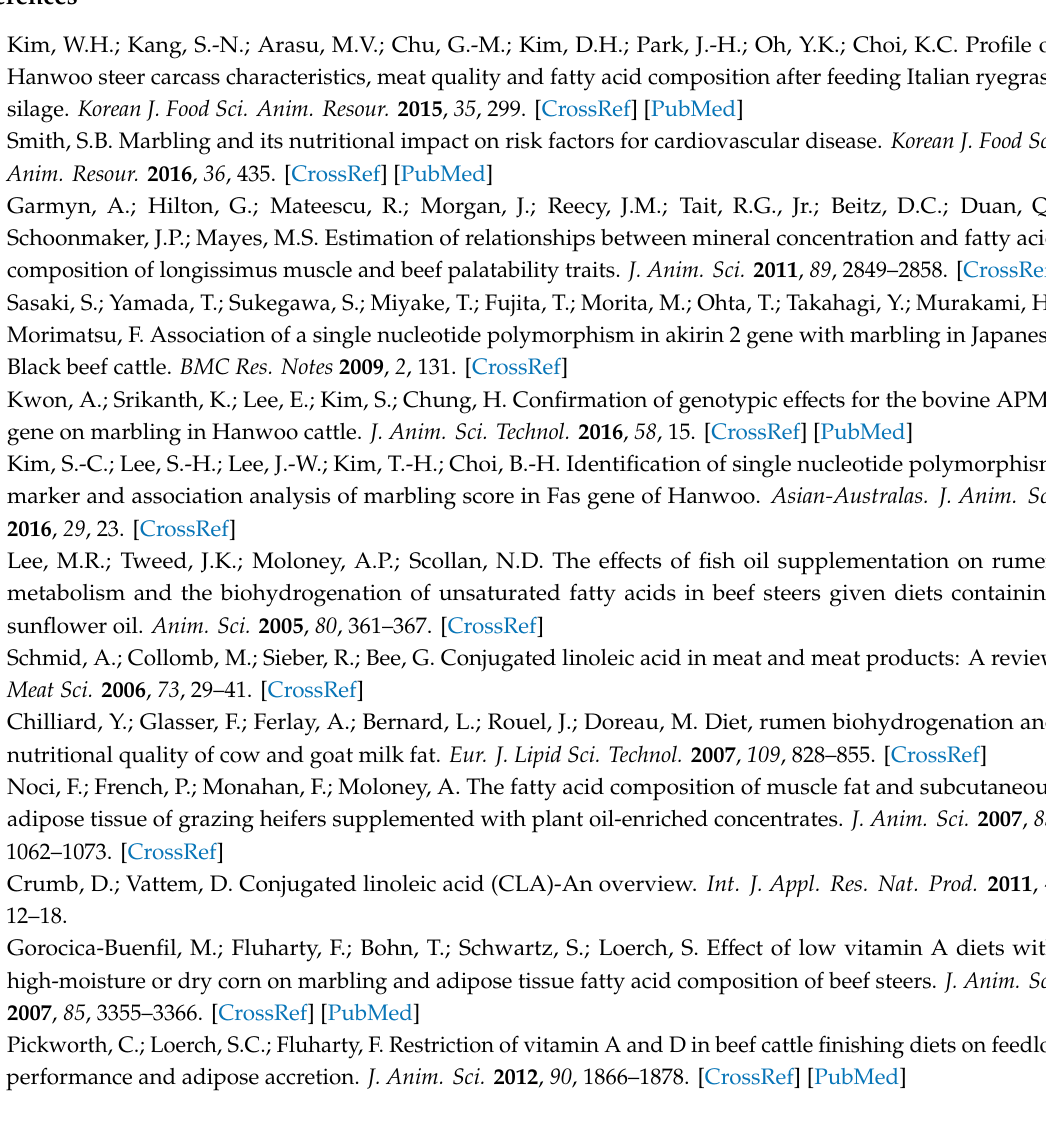
Table S1: Feed and nutrient composition of diets during the early weaning period, growing, and fattening stages. Table S2: Pairwise PERMANOVA results of early weaning diet e ff ect on the rumen microbiota of Hanwoo steers. Table S3: DADA2 denoising statistics of 16S rRNA gene amplicon sequencing variants from the rumen of Korean beef cattle resulting in di ff erent marbling score groups. Figure S1: Relative abundance barplots of major classified (A) phyla, (B) families, and (C) genera (each taxon found in more than 50% of the 14 rumen samples) of prokaryotes detected in the rumen of Korean beef